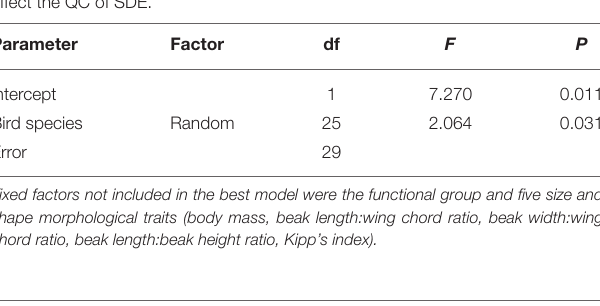
TABLE 6 | Result of mixed general linear model analyzing bird functional traits that affect the QL of SDE. Parameter Factor